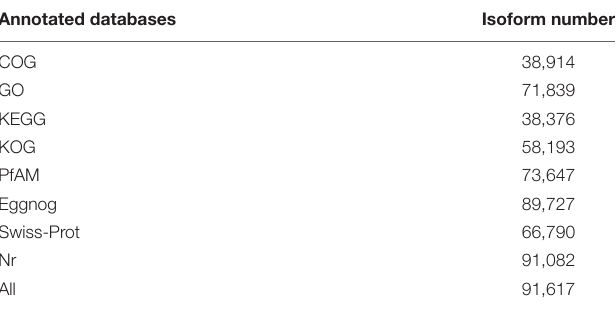
TABLE 3 | Functional annotation of S. superba transcriptome.